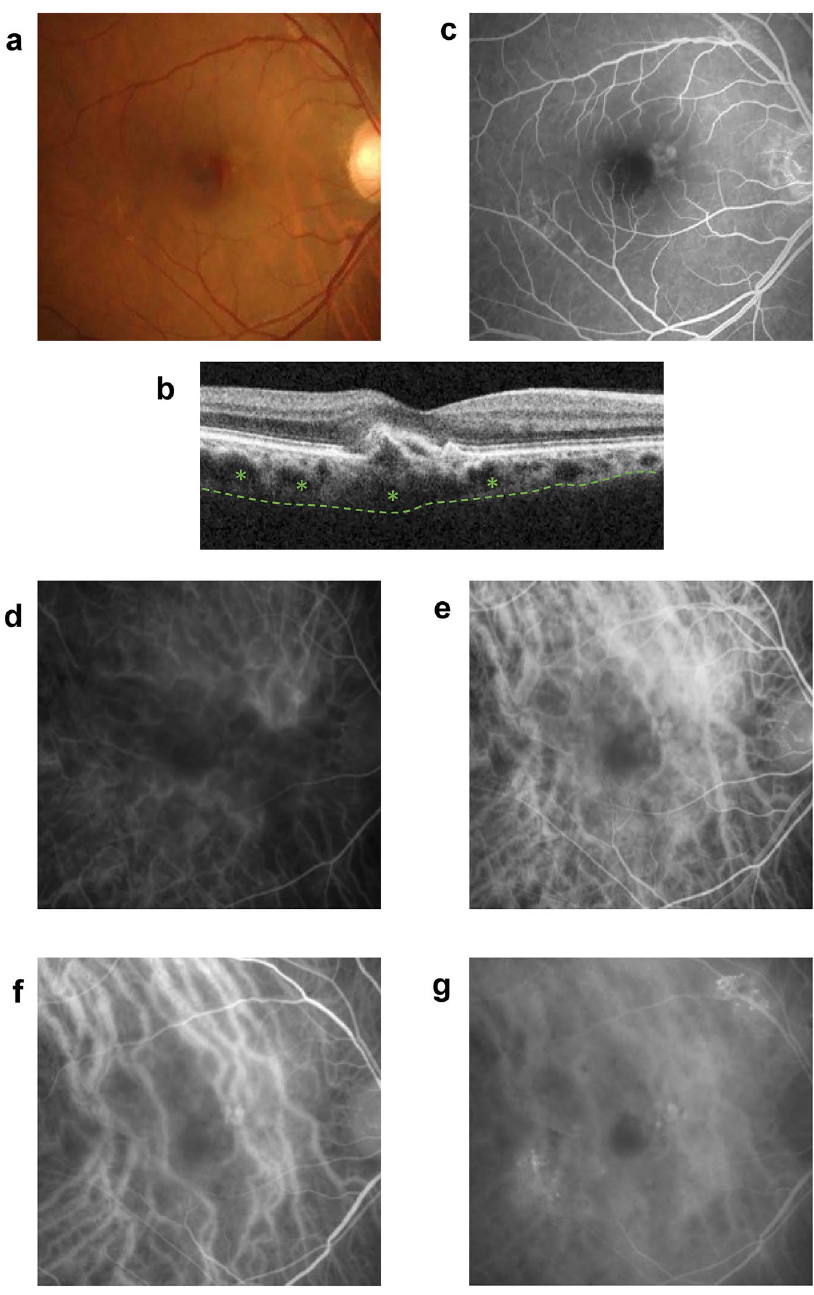
Figure 3. Representative case of pachychoroid neovasculopathy. ( a ) Fundus photograph of a 62-year-old female patient showing a retinal pigment epithelium (RPE) abnormality and a subretinal hemorrhage in the macular area. Large choroidal vessels can be seen on the nasal and temporal side of the macular area. ( b ) OCT image showing choroidal thickening, dilated choroidal pachyvessels with inner choroidal attenuation (asterisks). The dotted line represents the choroid-sclera interface. An RPE detachment can be seen at the fovea. ( c ) Fluorescein angiogram showing window defects and some discharge in the macular area in the early phase (22 s). ( d )–( g ) Indocyanine green angiogram showing dilated choroidal vessels with focal choroidal hyperpermeability and macular neovascularization (MNV) with polypoidal lesions at the macular area. (d; 14 s, e; 17 s, f; 29 s, g; 10 min 28